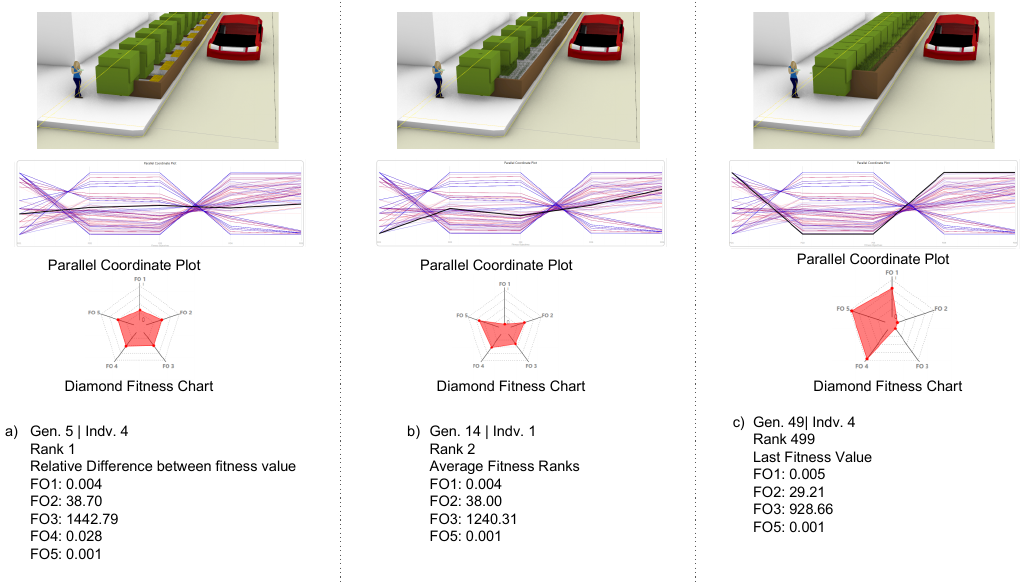
Figure 7. T-Agent revolutionary generative simulation agent alternative result 3D visualization models associated with its analytic parallel coordinate Plot and Diamond Fitness Chart: ( a ) Rank 1 produced model by T-Agent with it’s detailed Fitness Objective (FO) values illustration; ( b ) Rank 2 produced model by T-Agent with it’s detailed FO values illustration; ( c ) last rank produced model by T-Agent with its FO values illustration